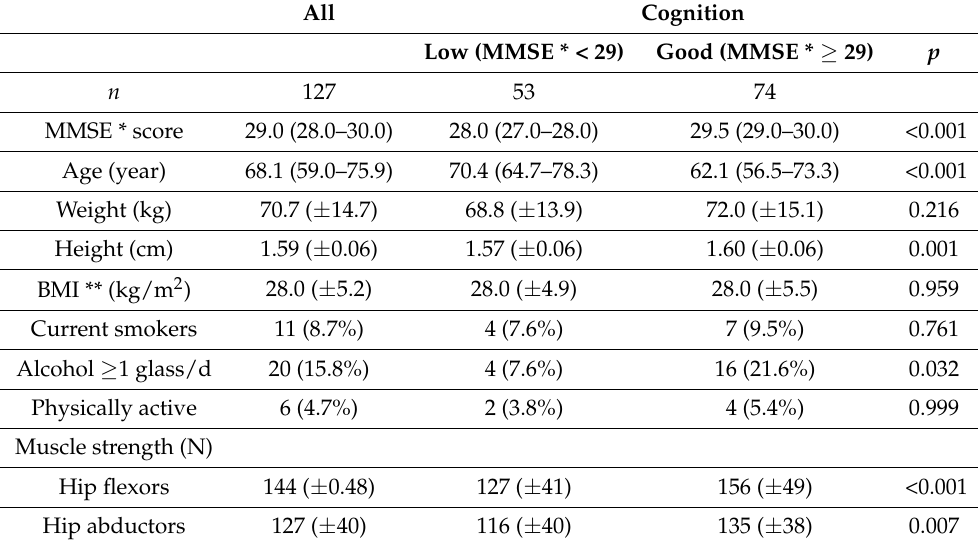
Table 1. Participant characteristics for the whole group and according to categories of cognition. Data are shown as mean ( ± SD), median (interquartile range, IQR), or number (%).